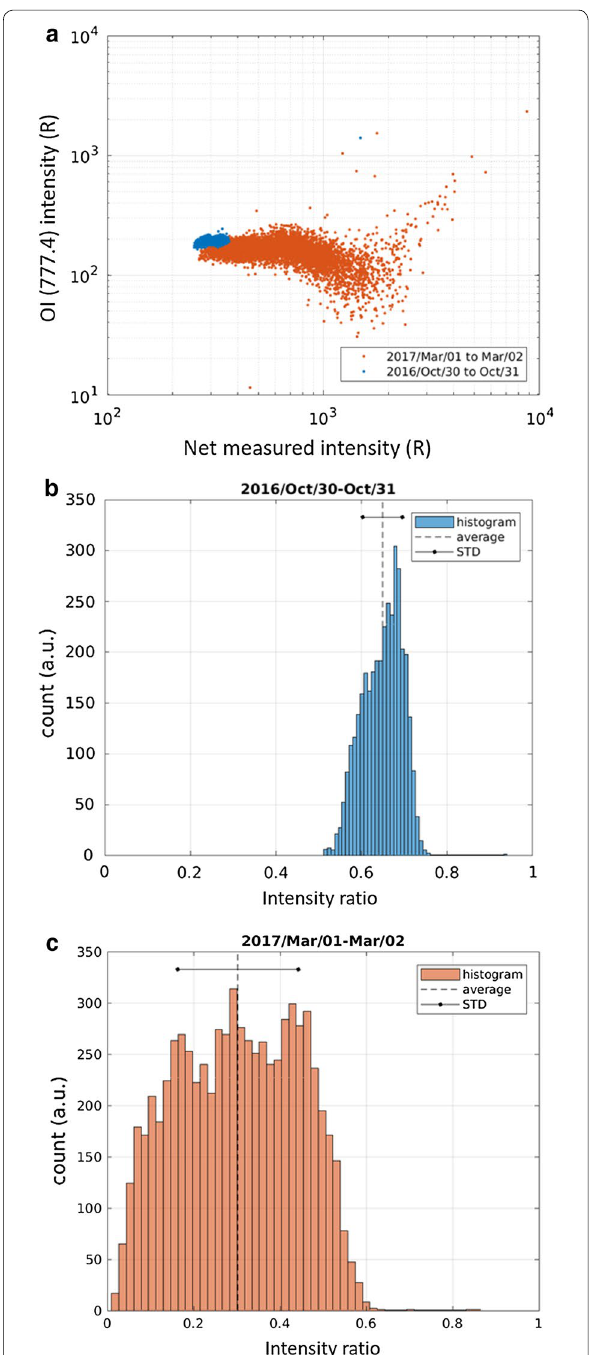
Fig. 3 a Relationship between estimated emission intensities of OI (777.4) ( I OI ) and the value to be measured through the optical filter that is mounted on the EMCCD camera ( I m ) on the nights of (blue) October 30–31, 2016 and (orange) March 1–2, 2017. b Histogram of the emission intensity ratio ( I OI / I m ) on night of October 30–31, 2016. The statistical average and standard deviation are marked by a black dash and a solid line with dots, respectively. c Same as panel b , but for data from the night of March 1–2,